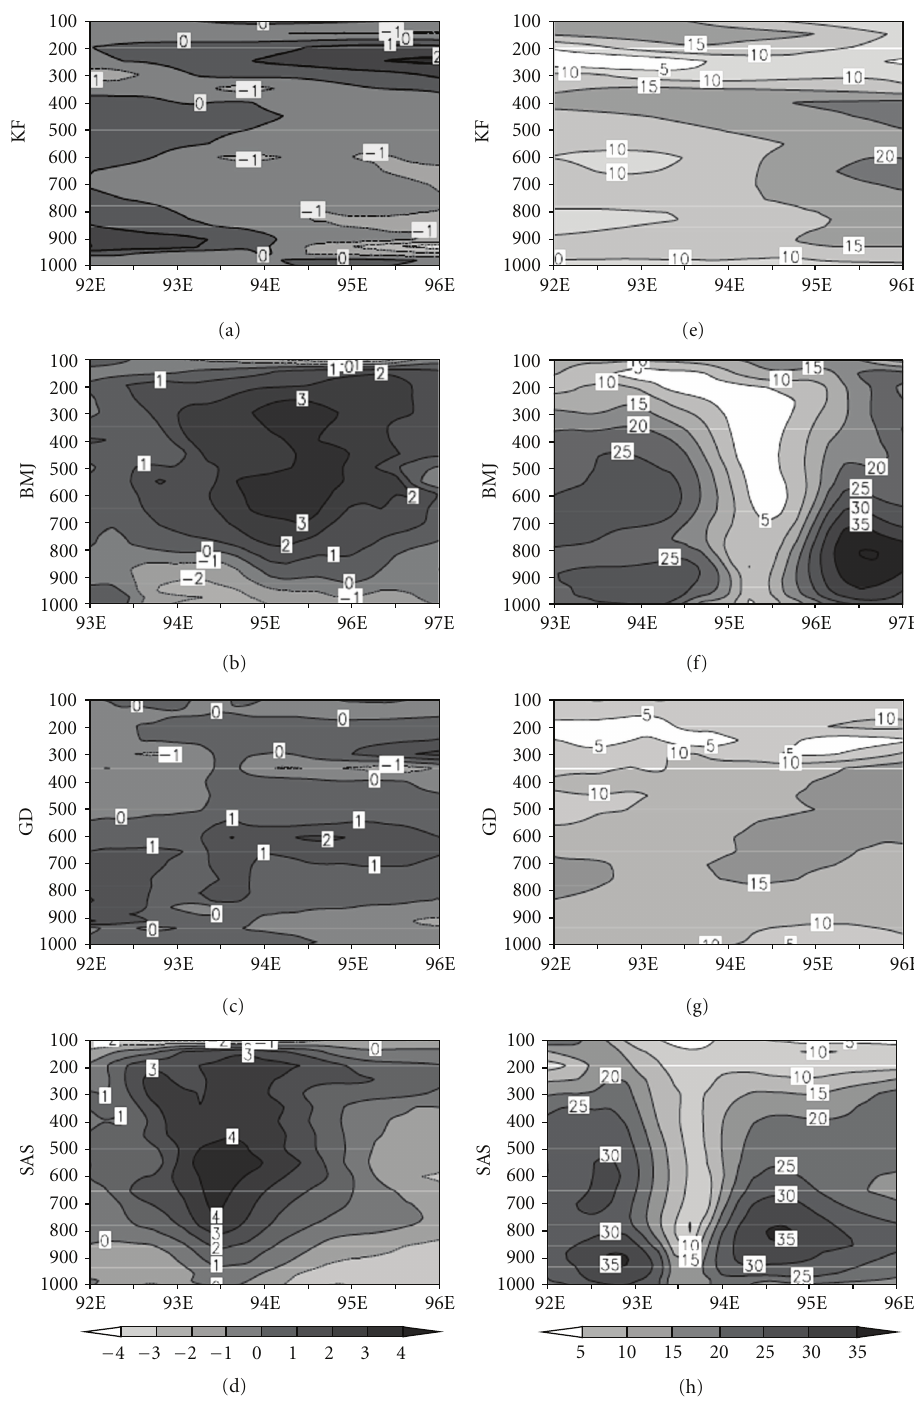
Figure 2: Temperature anomaly ( ◦ C) (left panel) and horizontal wind (ms − 1 ) (right panel) at the most intense period of the cyclone Nargis with di ff erent cumulus convective